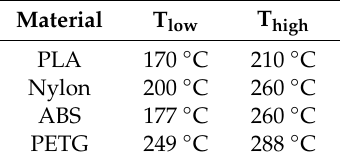
Table 4. Processing conditions for each ADFRC with a di ff erent thermoplastic